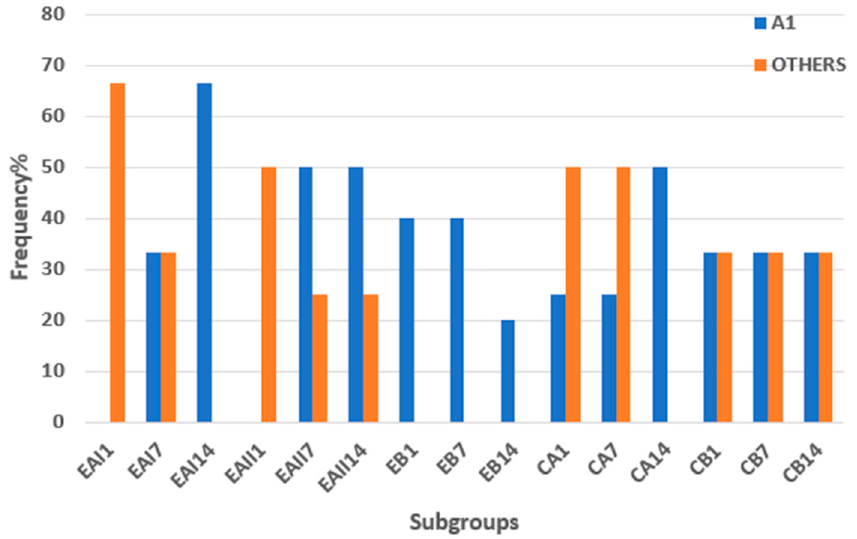
Figure 4. Frequency% of A1 shades across subgroups. EB (choline citrate gel) showed the A1 shade after 7 h (1 night), 49 h (7 nights), and 98 h (14 nights) of treatment duration as compared to the CA (commercial at-home 16% carbamide peroxide gel). The A1 shade was achieved earlier, i.e., after 7 h and 49 h of treatment with choline citrate gel (EB), in comparison to the commercial at-home 16% carbamide peroxide (CA) that showed the A1 shade after 98 h of